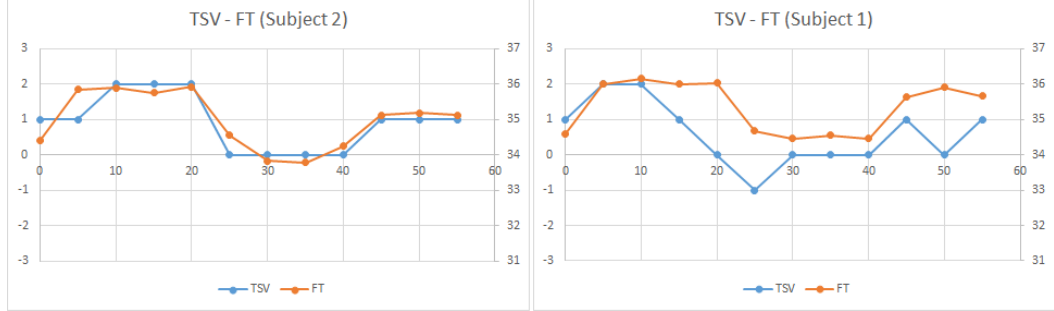
Figure 6. Forehead temperatures (FT) plotted versus thermal sensation votes (TSV) for two different subjects. ( left ) best correlated case; ( right ) worst correlated case.